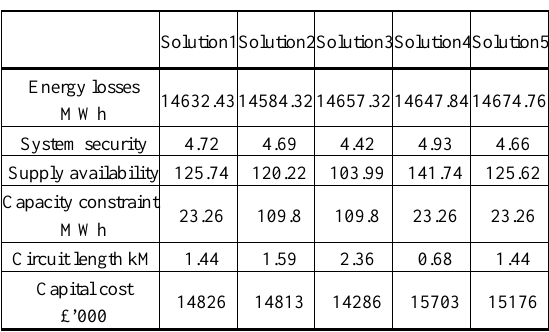
Table 4. The generated data of five solutions under the indirect criteria